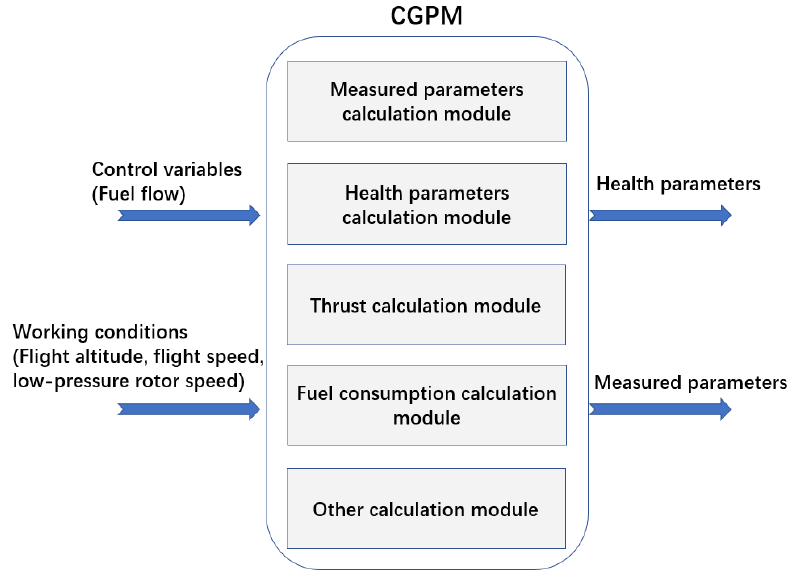
Figure 3. Structure of Component-level Gas Path Model.